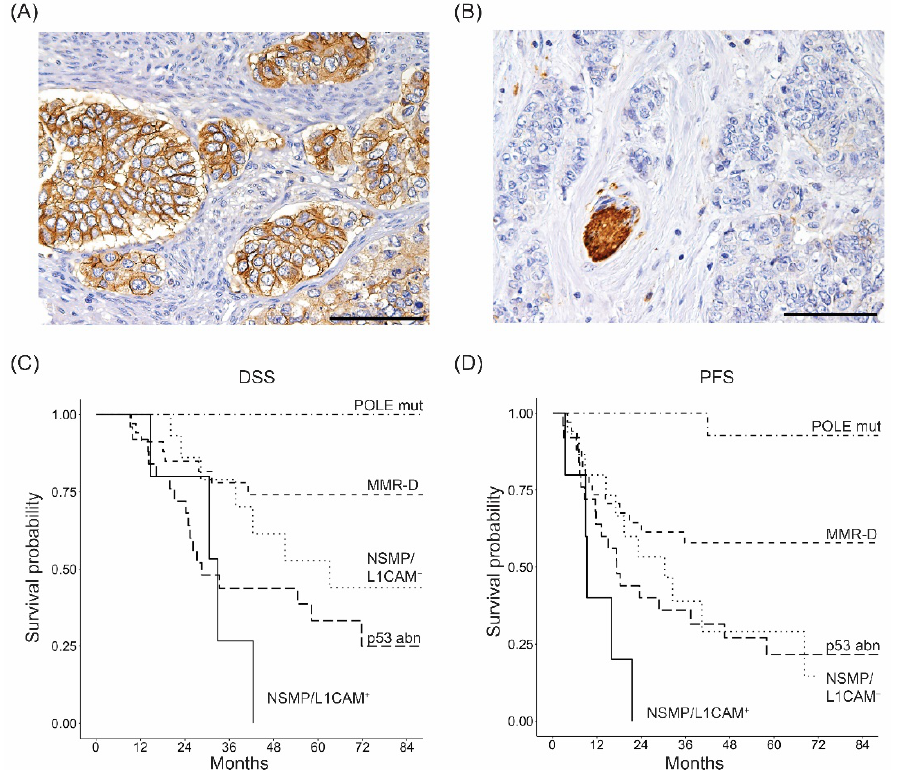
Figure 1. IHC staining for L1CAM in NSMP EC samples of the Brescia Cohort. Two representative cases of L1CAM-positive ( A ) and -negative ( B ) expression in tumor cells. The strong staining of the nerve ( B ) represents the internal positive control. Original magnification: 200×, scale bar 100 µm. Kaplan–Meier survival curves for disease specific survival ( C ) and progression-free survival ( D ) according to molecular classification, with the NSMP group stratified based on L1CAM positivity. We validated the survival model for PFS on an independent cohort (ENITEC Co- hort) of 47 high-risk EC patients, harboring 1 POLE, 7 MMR-D, 22 NSMP, and 17 p53abn especially in the NSMP subgroup, where only 18% of patients relapsed or died of the dis- ease. Due to this different survival rate, we recalibrated the survival models developed on the Brescia cohort using logistic calibration. The predicted 36 months PFS rates using the model accounting for L1CAM were 0.63 and 0.66 for the NMSP L1CAM-positive and L1CAM-negative patients, respectively, with an observed PFS rate of 0.75 and 0.90. The model not accounting for L1CAM (based only on molecular classification) reported a pre- dicted survival of 0.66 for L1CAM-positive and 0.64 for L1CAM-negative groups. While the estimates still underestimate the true survival rate, due to the substantial difference between the two cohorts, adding L1CAM has actually achieved a better ranking within the NSMP subgroups. This suggests a lower PFS, something coherent with the observed results, for the L1CAM-positive group. Moreover, the concordance indexes (C-indexes) between observed and predicted survival for the NSMP subgroup for the two models were 0.75 for the extended model with L1CAM, versus 0.68 for the baseline model. Thus, our results indicate that L1CAM expression, when added to the baseline model, improves the performance in predicting recurrence. 3.5. L1CAM Correlates with the Time to Recurrence After Platinum-Based Chemotherapy in NSMP High-Risk ECs We further investigated whether the stratification of the NSMP subgroup based on L1CAM status, besides being a prognostic factor, could also be informative of the time to